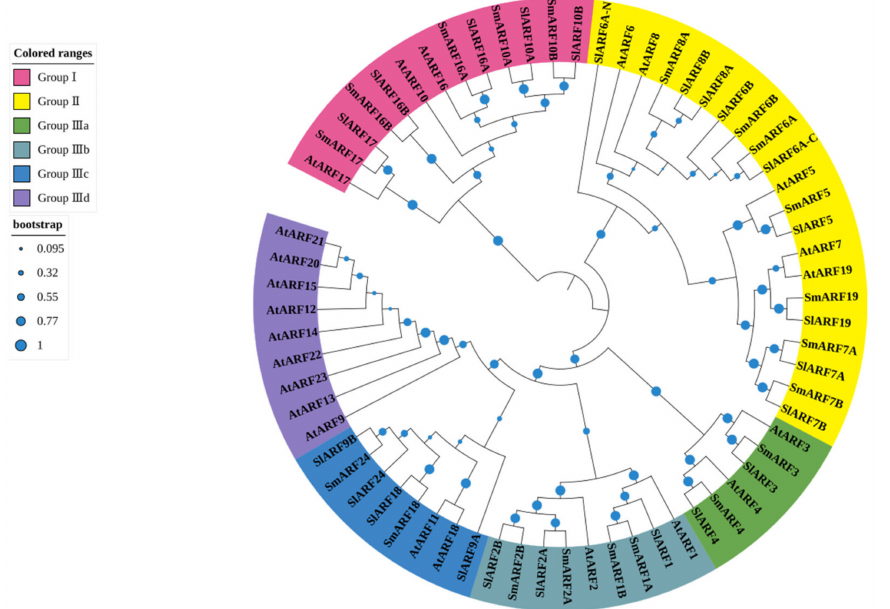
Figure 2. Phylogenetic analysis of genes encoding auxin response factors (ARFs) in Arabidopsis , eggplant, and tomato. A phylogenetic tree was constructed using MEGA 7 software through the neighbor–joining method, with 1000 bootstrap replicates using ARF protein sequences from eggplant (20), Arabidopsis (23), and tomato